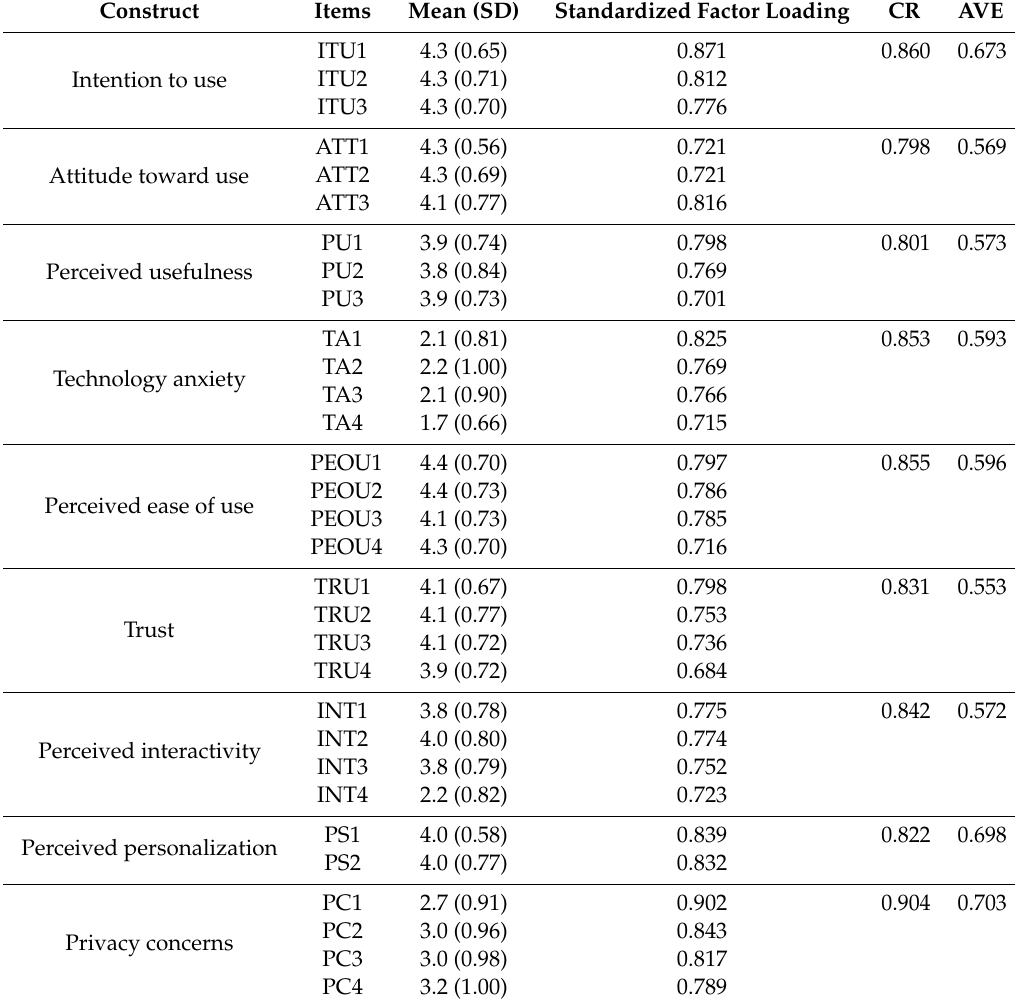
Table 3. Means, reliability, and convergent